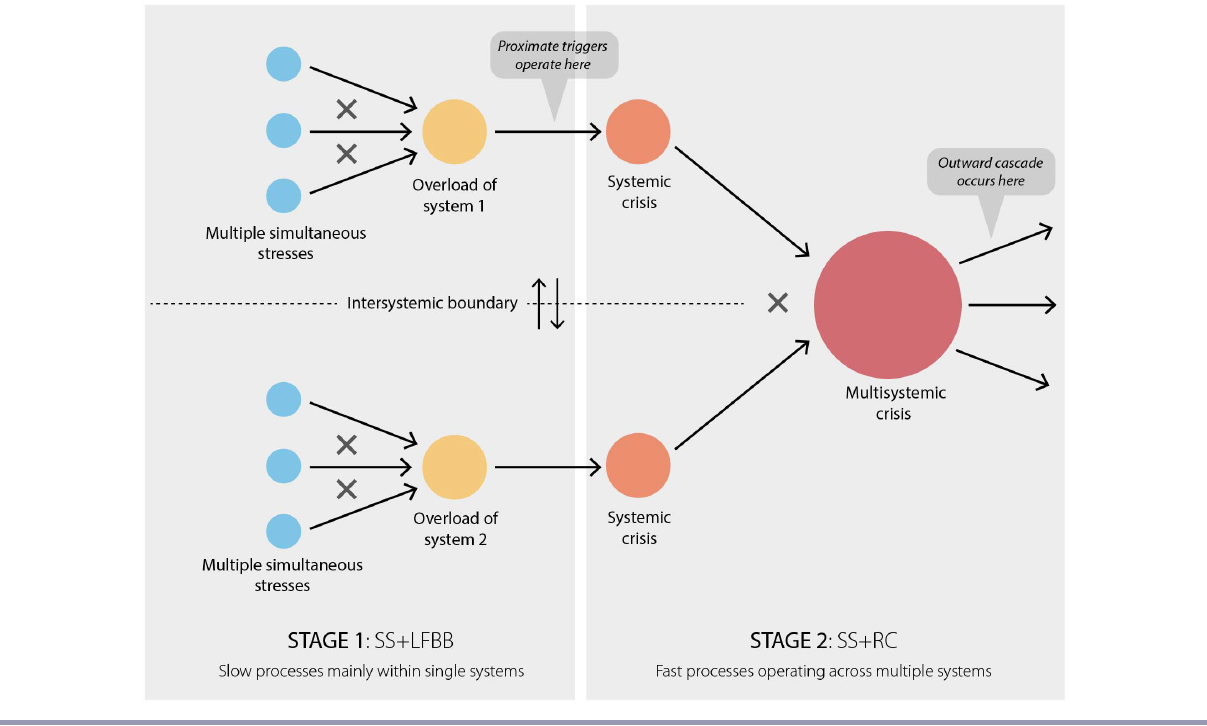
Fig. 1 . Synchronous failure: a conceptual framework showing the emerging causal architecture